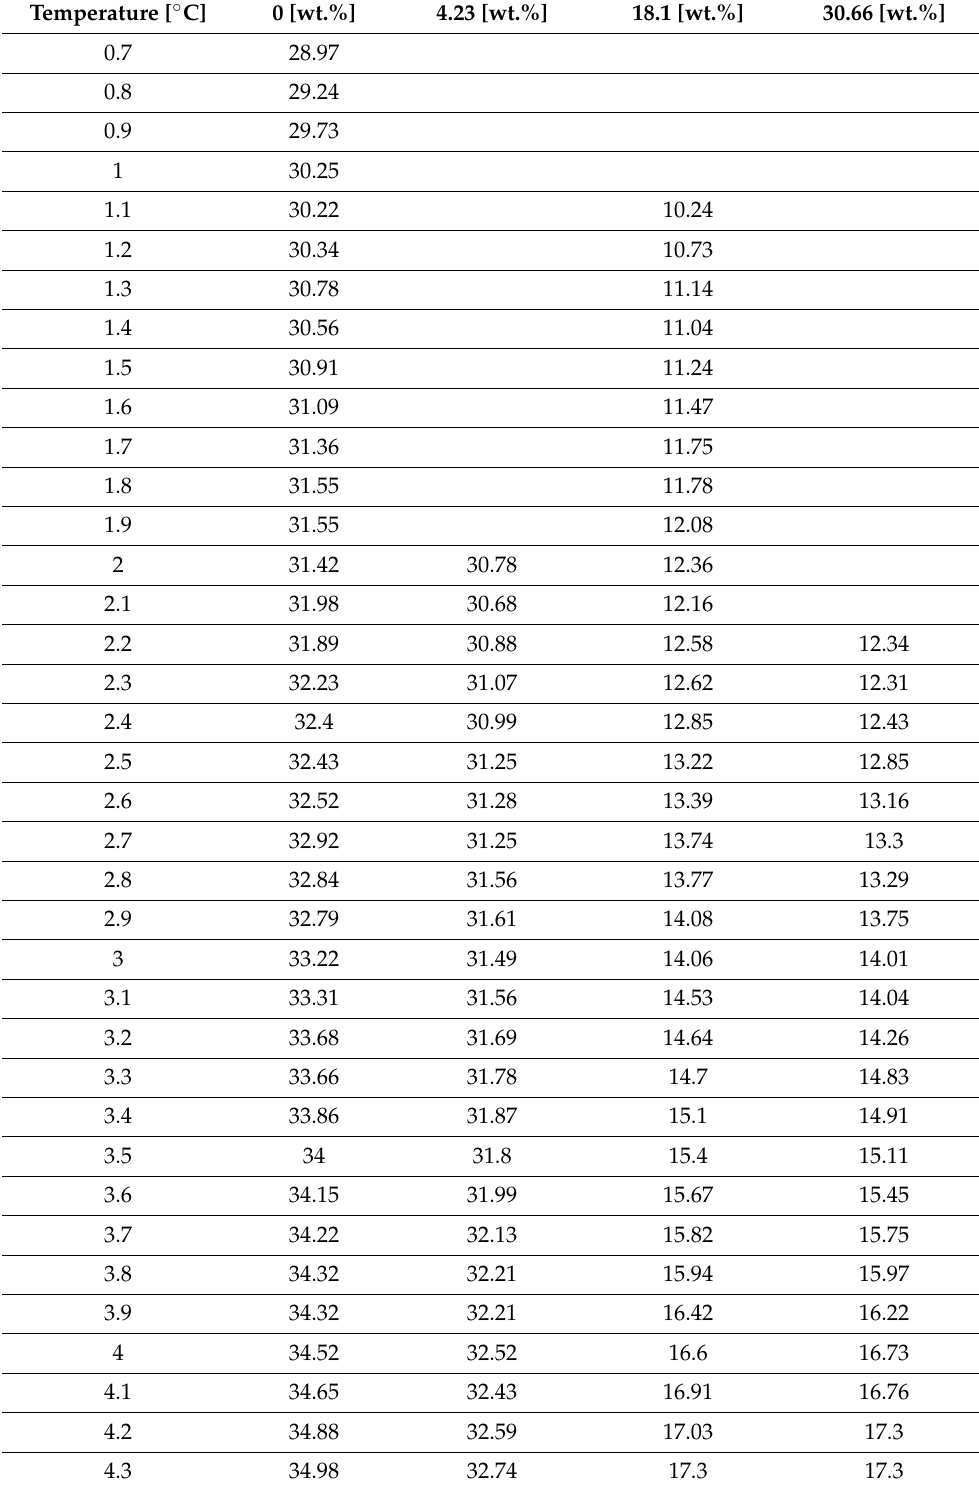
Table 3. Equilibrium values for carbon dioxide hydrate in the presence of CuSn12 powder, analyzed with four different